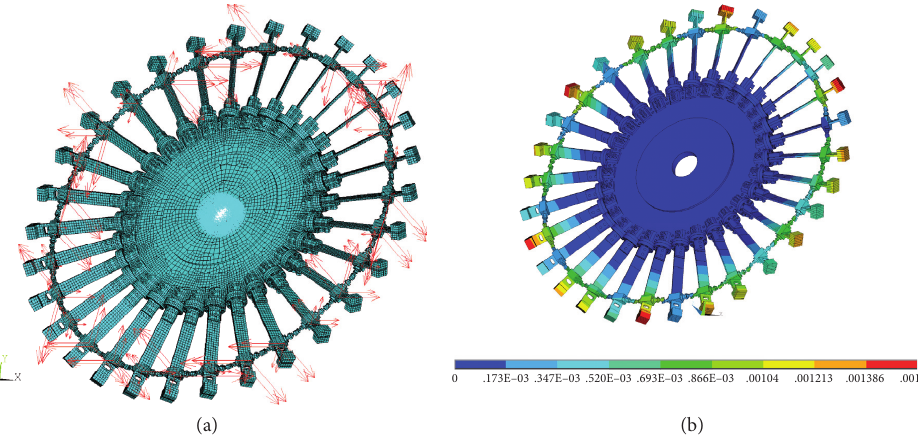
Figure 12: (a) Distribution of modal forces around the wheel (red vector). (b) Contour maps of initial displacements (m) of the wheel—6ND